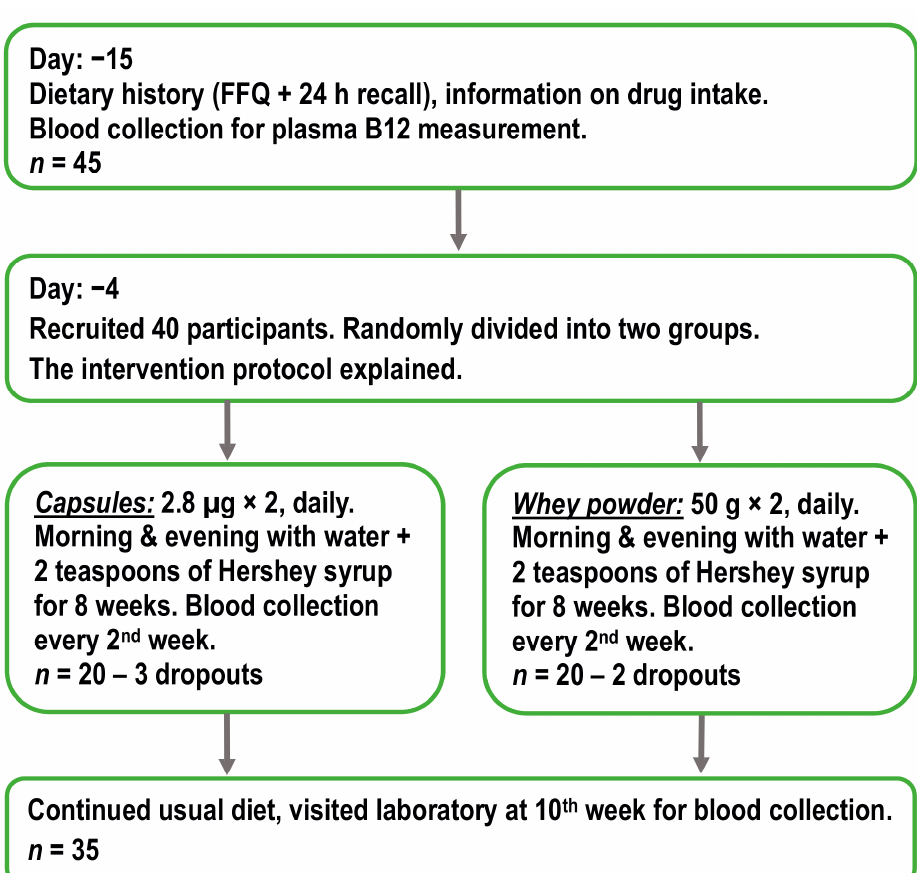
Figure 1. The scheme of overall study design (FFQ, food frequency questionnaire).